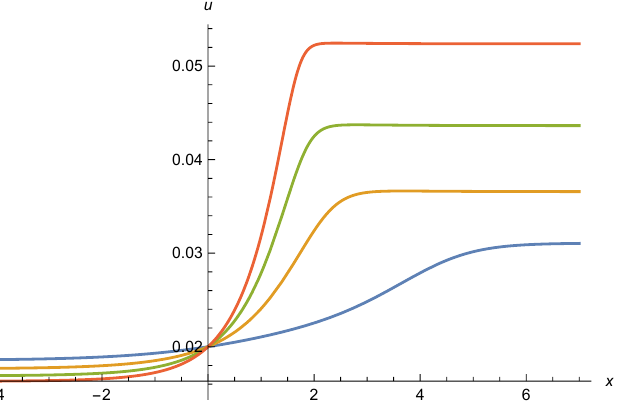
Figure A1. Effective potential u ( x ) as function of x = ln ( ˜ ρ ) in presence of a Yukawa coupling, y 2 /4 π = 1/40. The curves (from bottom to top on the right part) for w 0 = 0.042, 0.046, 0.052, and 0.06. Other parameters are N = 10, ¯ N f = 1, and initial values are set as u ( x = 0 ) =